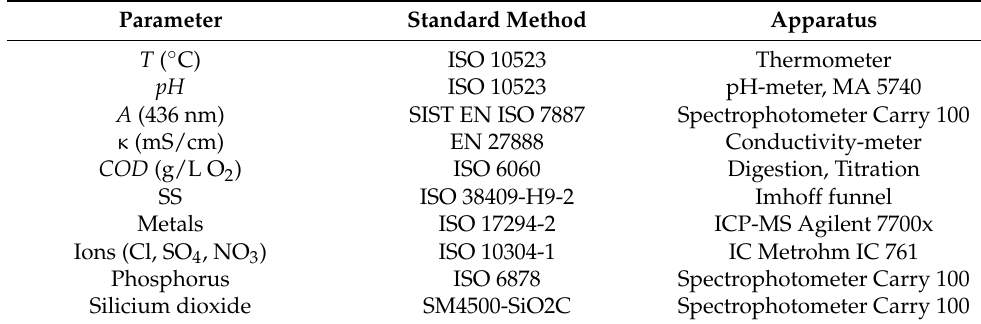
Table 2. The methods used for wastewater chemical